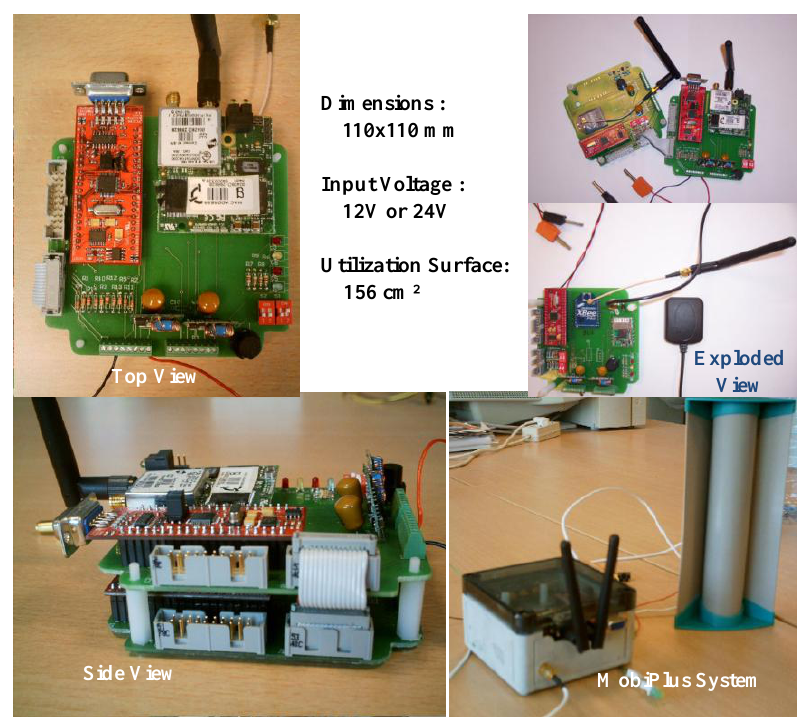
Figure 5. Prototype of the Mobi+